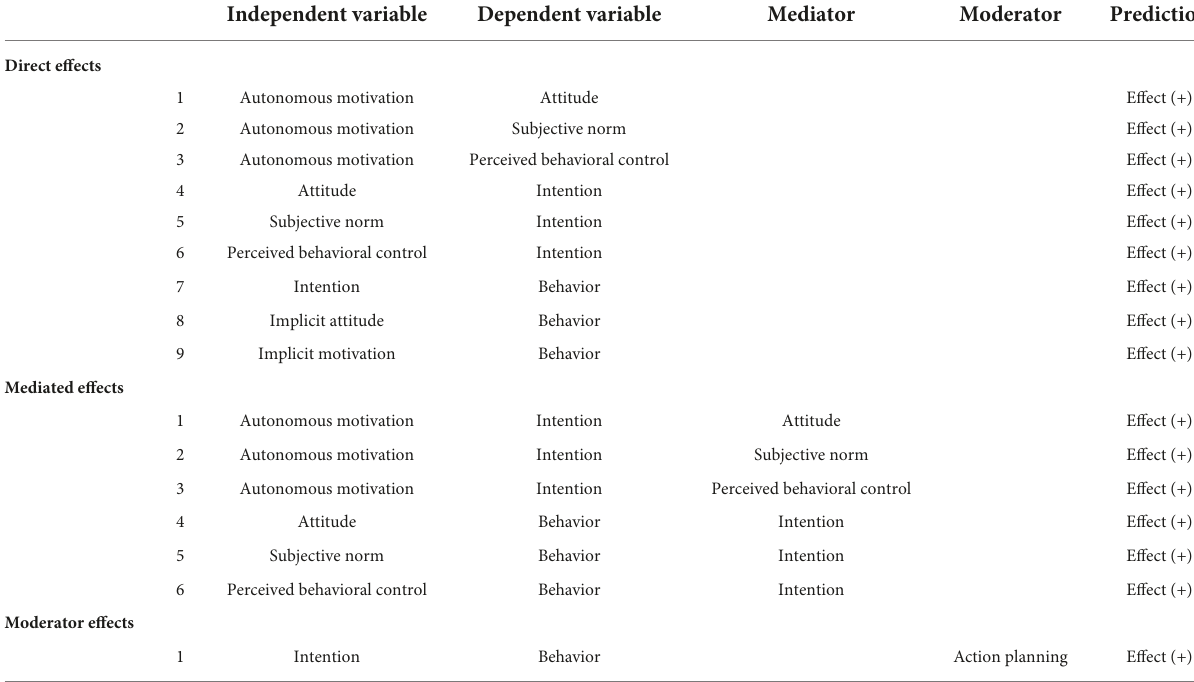
TABLE 3 Integrated Behavior Change Model predictions for positive health behaviors. Independent